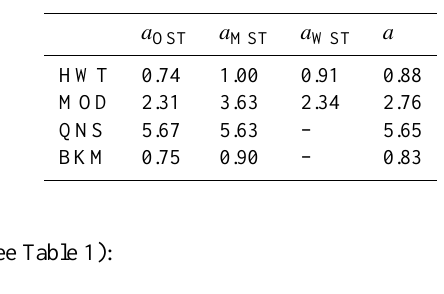
Table 2. Calibration coefficients a for every possible combination of X-band radar (HWT, MOD, QNS and BKM) and MRR (OST, MST and WST) and the average coefficient in